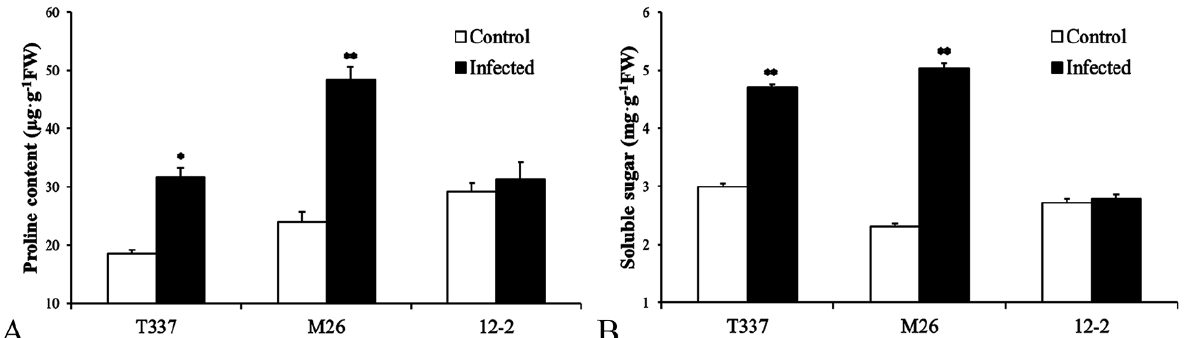
Figure 7. Effects of F. proliferatum MR5 on leaf proline and soluble-sugar contents: ( A ) proline content; ( B ) soluble-sugar content. The Student’s t -test was used to detect differences between the control and infected treatments within a rootstock. * p < 0.05; ** p < 0.01.